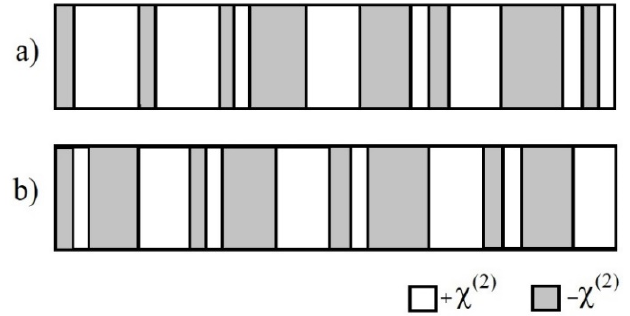
Figure 1. Sketch of the QPM lattice with domains of thicknesses d 1 and d 2 and alternating sign of the nonlinear response ( χ ( 2 ) ). Here, d 1 and d 2 are the coherence lengths of the interactions 2 ω = ω + ω and 3 ω = 2 ω + ω , respectively. ( a ) QPM with unequal domain thicknesses in each segment, and ( b ) QPM with equal domains in each segment.